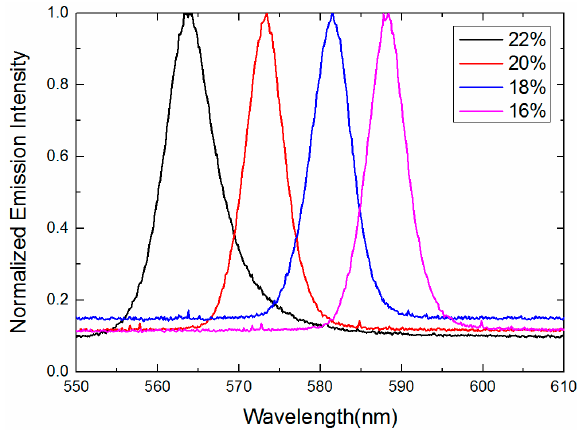
Figure 6. Emission spectra of templated SPLC systems with different concentrations of the polymer.